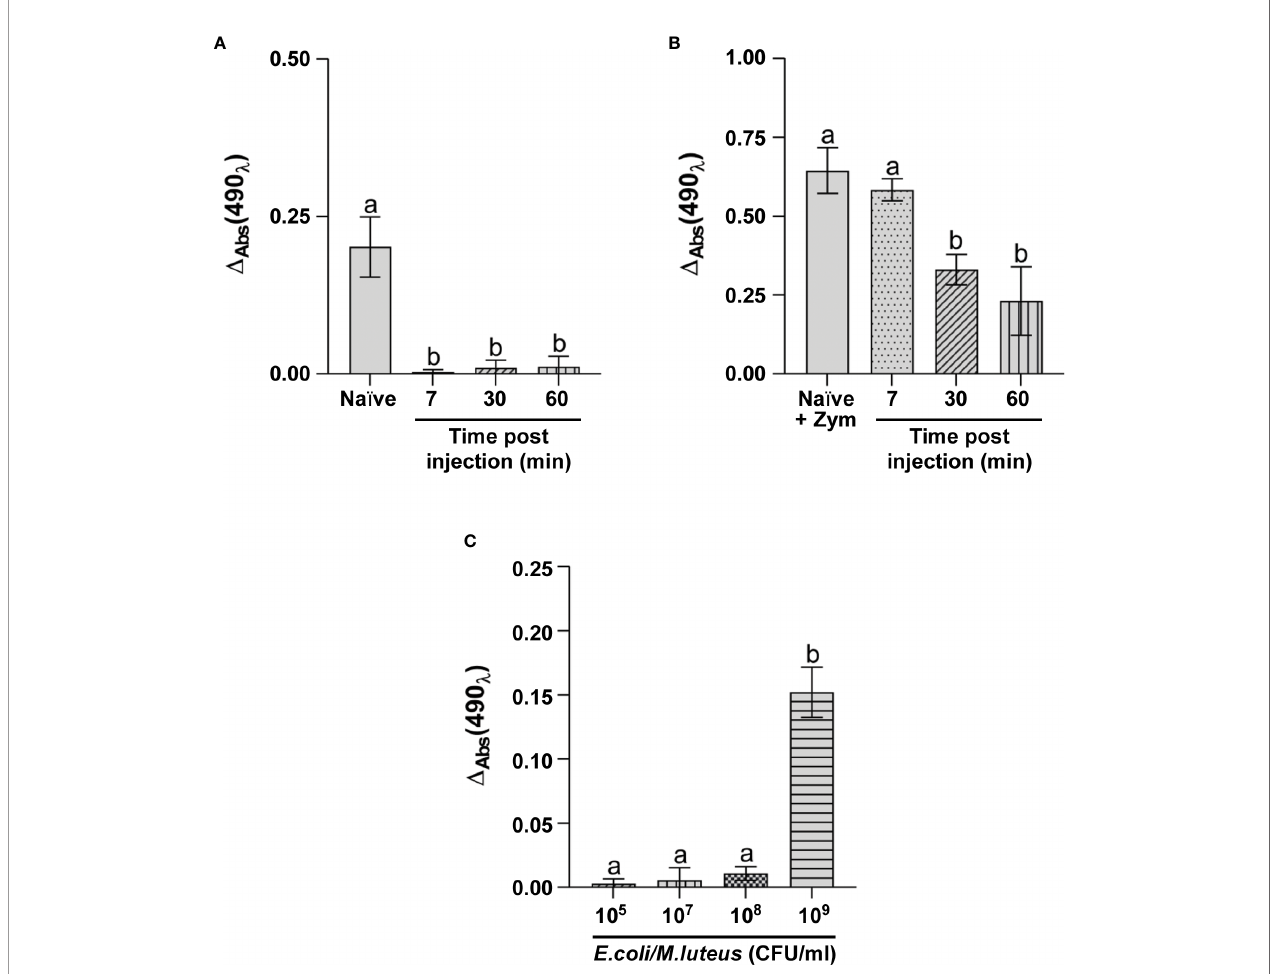
FIGURE 5 | Analysis of PO system activation. D Abs at 490 nm of phenoloxidase in (A) hemolymph of naïve larvae (Naïve) and larvae infected for 7, 30 and 60 minutes with 10 5 CFU/ml of E. coli / M. luteus mix; (B) hemolymph isolated from naïve larvae (Naïve + Zym) and larvae infected for 7, 30, and 60 minutes with 10 5 CFU/ml of E. coli / M. luteus , treated with Zymosan; (C) hemolymph isolated from larvae infected for 7 minutes with different concentrations of E. coli / M. luteus mix. Values represent mean ± s.e.m. Different letters indicate statistically signi fi cant differences among treatments (One Way ANOVA: A ) F 3-8 = 41.54, p < 0.0001; B ) F 3-8 = 22.95, p = 0.0003; C ) F 3-8 = 122.7, p <